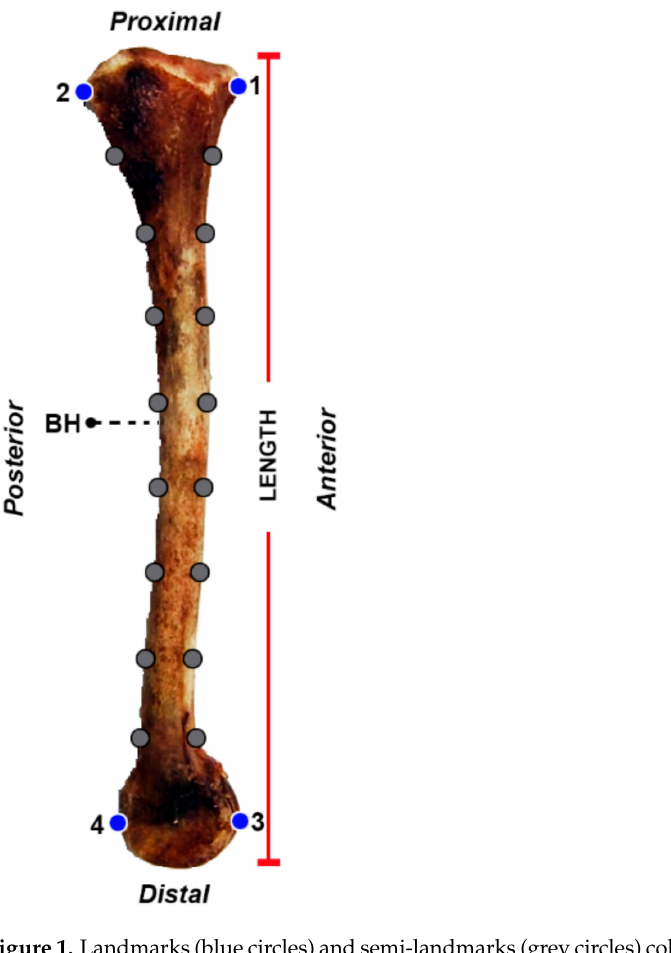
Figure 1. Landmarks (blue circles) and semi-landmarks (grey circles) collected on the tibia : (1) Proximal anterior and (2) proximal posterior epiphyses; (3) distal anterior and (4) distal posterior epiphyses. Bio- metrics collected along the tibia : Length and maximum width of the arch described by the bone (BH). Morphometric software of the TPS series are freely available (http://life.bio.sunysb.